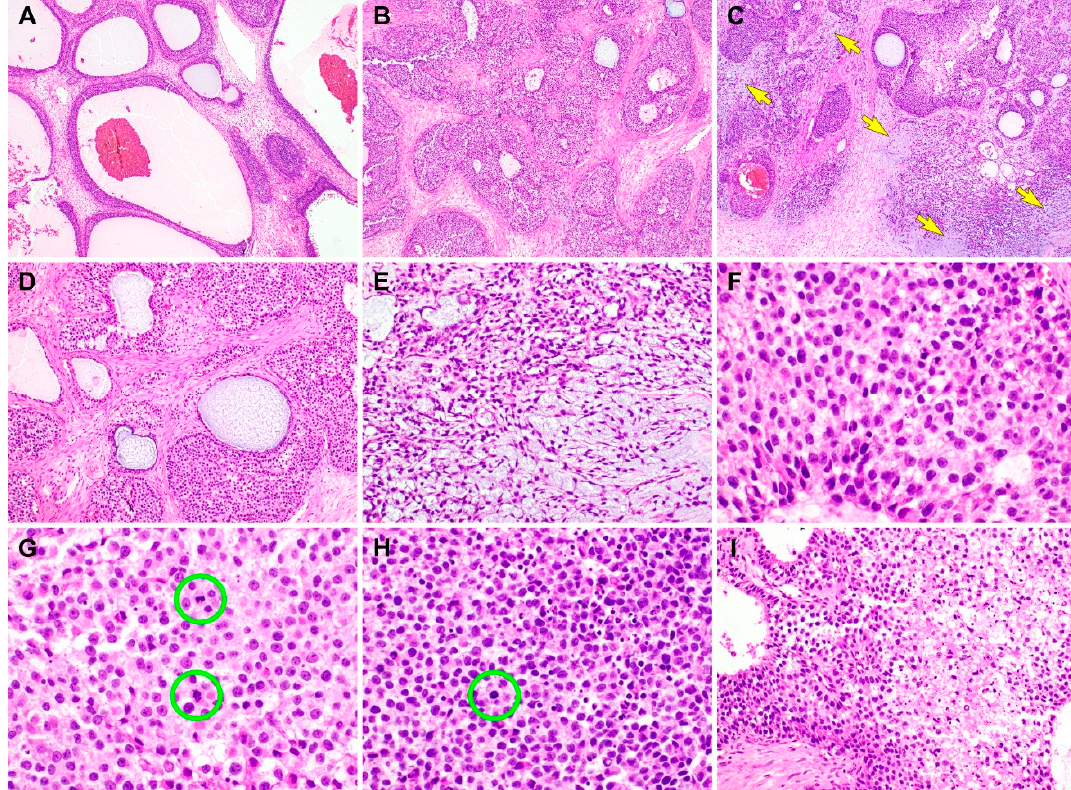
Figure 2. Histological findings of the juvenile granulosa cell tumor (JGCT) component of gynandroblastoma. ( A ) The tumor has many follicles that vary in size and shape [1] . The thickness of the cells lining the follicles also varies. ( B ) The tumor cells form variable-sized solid nodules punctuated by small microcysts. The intervening stroma is fibrotic or edematous. ( C ) Several foci show basophilic matrices (yellow arrows) that are located adjacent to or merge with the solid cellular nodules. ( D ) The follicles contain secretions that are eosinophilic, though they are more often basophilic. ( E ) In the background of the basophilic, myxoid stroma, the bipolar or stellate-shaped cells proliferate diffusely. ( F ) On high-power magnification, the JGCT cells typically possess an abundant eosinophilic or a pale amphophilic cytoplasm. Their nuclei are round to oval and lack intranuclear